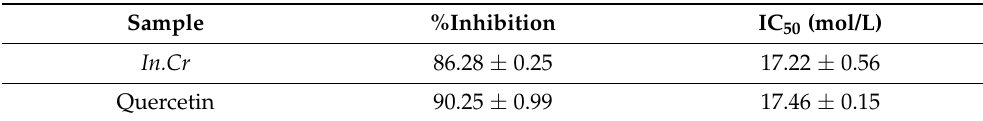
Table 1. IC 50 Table 1. IC 50 data.